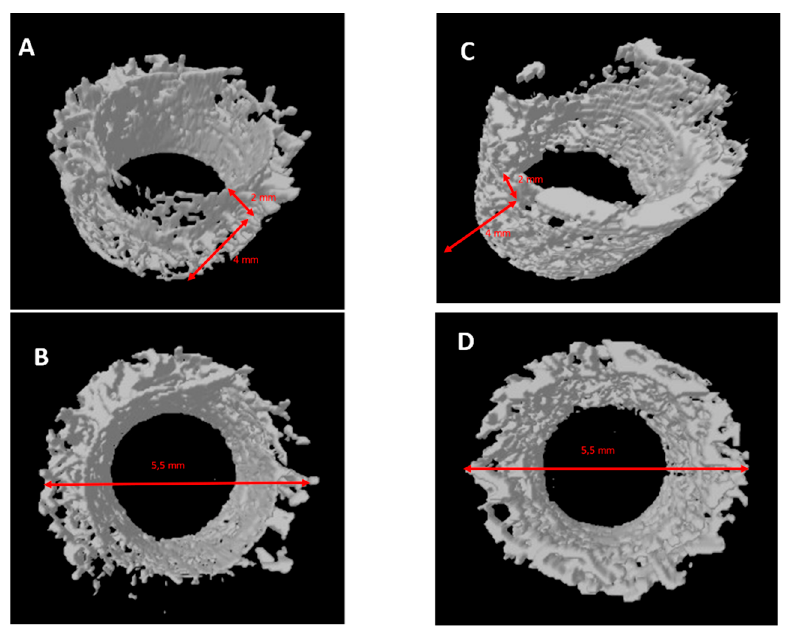
Figure 10. ( A , B ) PMMA implant. Micro-CT shows a mineralized bone with small medullary space.